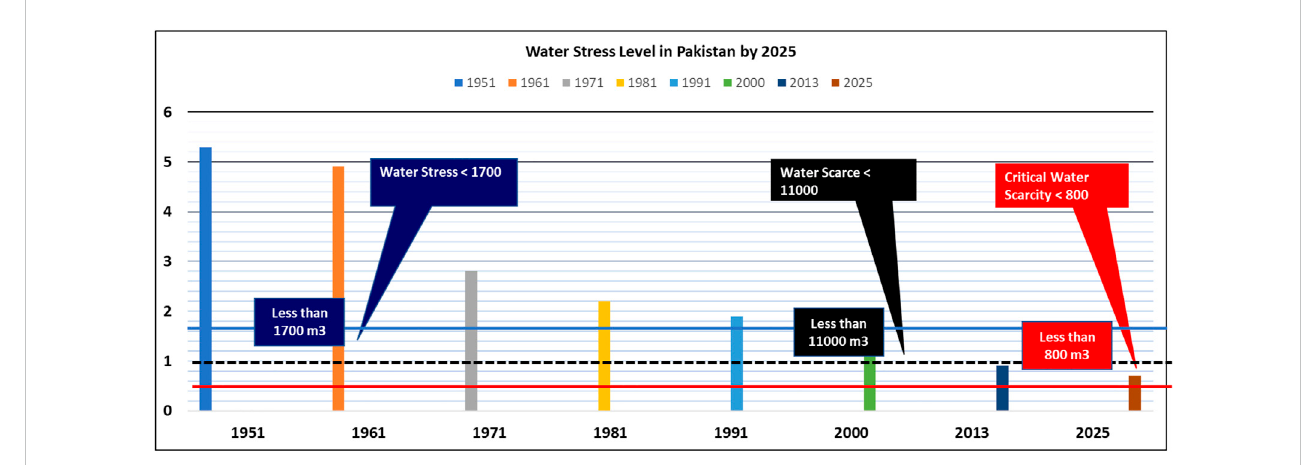
FIGURE 6 Water stress level in Pakistan by 2025.